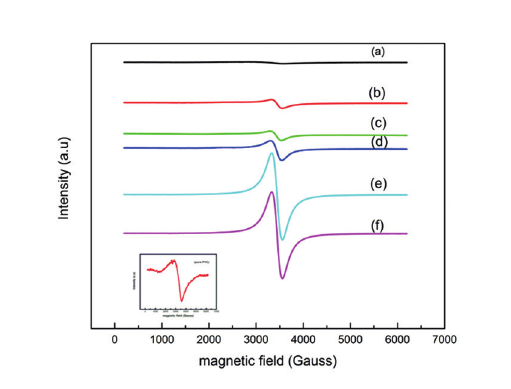
Figure 10: EPR spectra of pure and Mn 2+ doped PVC polymer films (a) pure (b) 1mol% (c) 2 mol% (d) 3 mol% (e) 4 mol% (f) 5 mol.